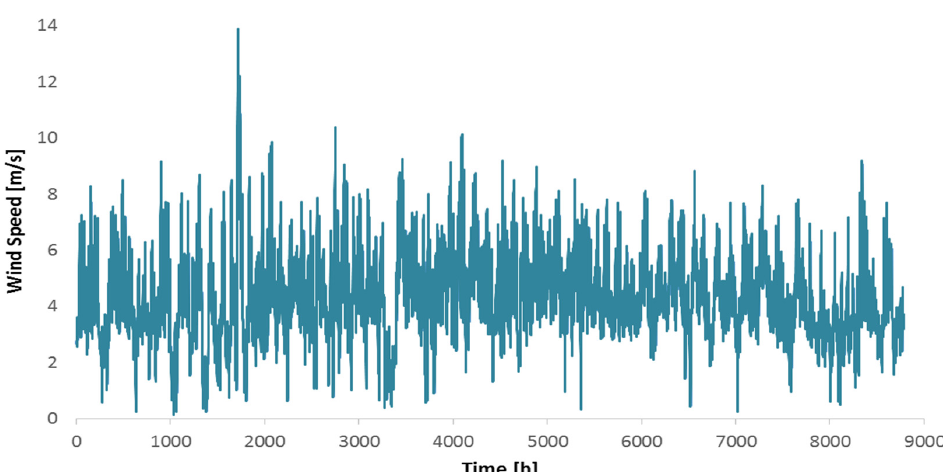
Figure 4. The yearly ambient temperature of the studied area.